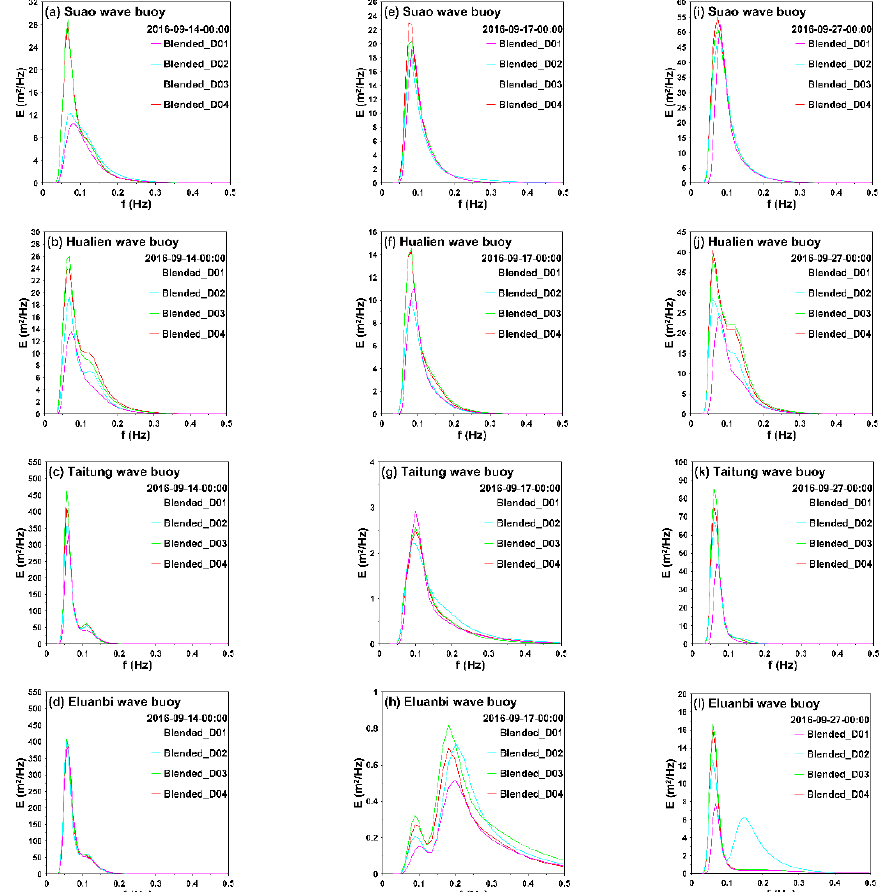
Figure 15. Comparison of the one-dimensional wave energy spectra at the Suao, Hualien, Taitung, and Eluanbi wave buoys using the four computational domains and blended winds field at ( a – d ) 00:00 on 14 September 2016, ( e – h ) 00:00 on 17 September 2016, and ( i – l ) at 00:00 on 27 September 2016.